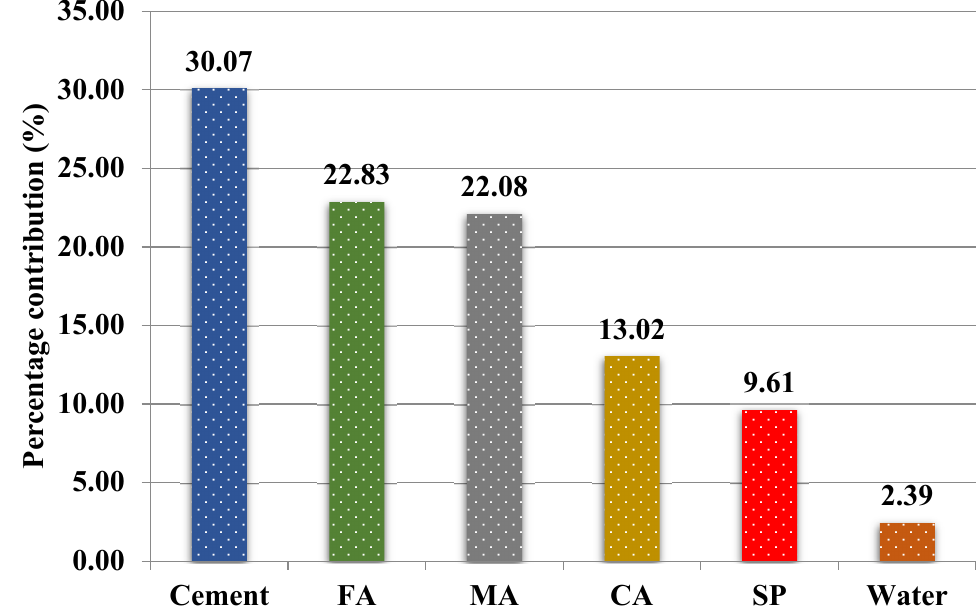
Figure 10. Contributions of input variables toward splitting tensile strength in the XG Boost model. Where FA = fine aggregate, MA = mineral admixture, CA = coarse aggregate, and SP = superplasti- cizer.